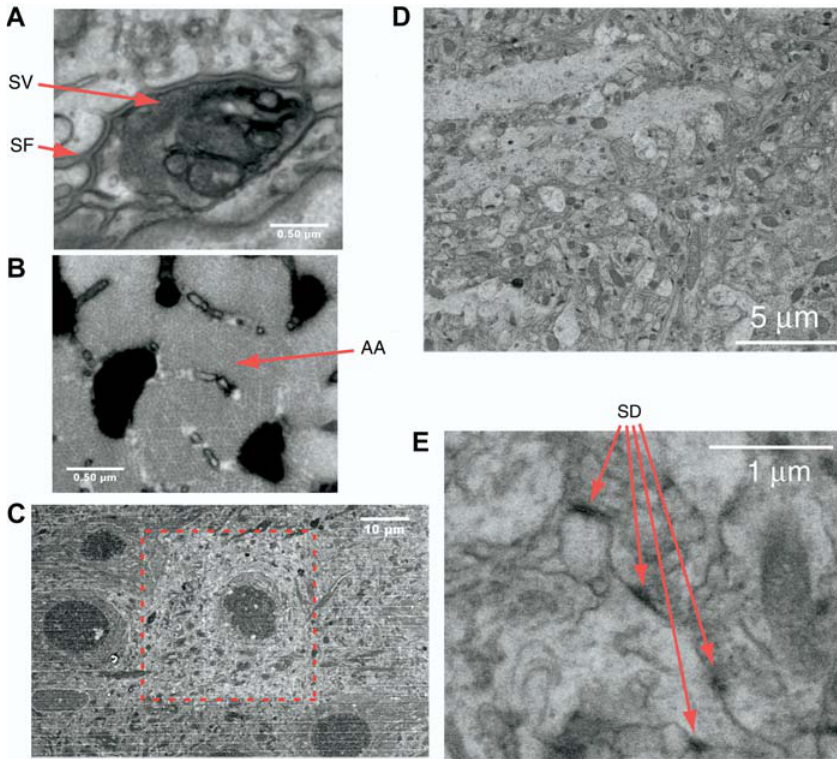
Figure 1. Resolution and Contrast Using the Backscattered Electron Signal (A and B) Presynaptic vesicles (SV) and postsynaptic folds (SF) are clearly visible (A) in a motor endplate preparation embedded in Spurr’s resin. Similarly, the hexagonal array of actin filaments (AA) can be clearly resolved (B) in a different region from the same image (both images were smoothed using the ImageJ ‘‘ smooth ’’ command). Imaging conditions for (A) and (B): electron energy, 7.5 keV; spot, 3.5; chamber pressure, 30 Pa (H 2 O); pixel dwell time, 30 l s. The scanning resolution was 6.7 nm/pixel. (C) The effect of beam exposure on the block surface. Note the increased bright- ness and the lack of chatter in the central region (inside the dashed rectangle), from which a stack was acquired at higher resolution before taking the image shown. The tissue was rat neo- cortex embedded in Spurr’s resin. Imag- ing conditions for (C): electron energy, 7.5 keV; spot, 3; digital resolution for stack acquisition, 26.7 nm/pixel; dwell time, 30 l s. (D and E) Cortical tissue embedded in Epon. Synapses (SD) are clearly discern- able (E). Imaging conditions for (D) and (E): electron energy, 7.5 keV